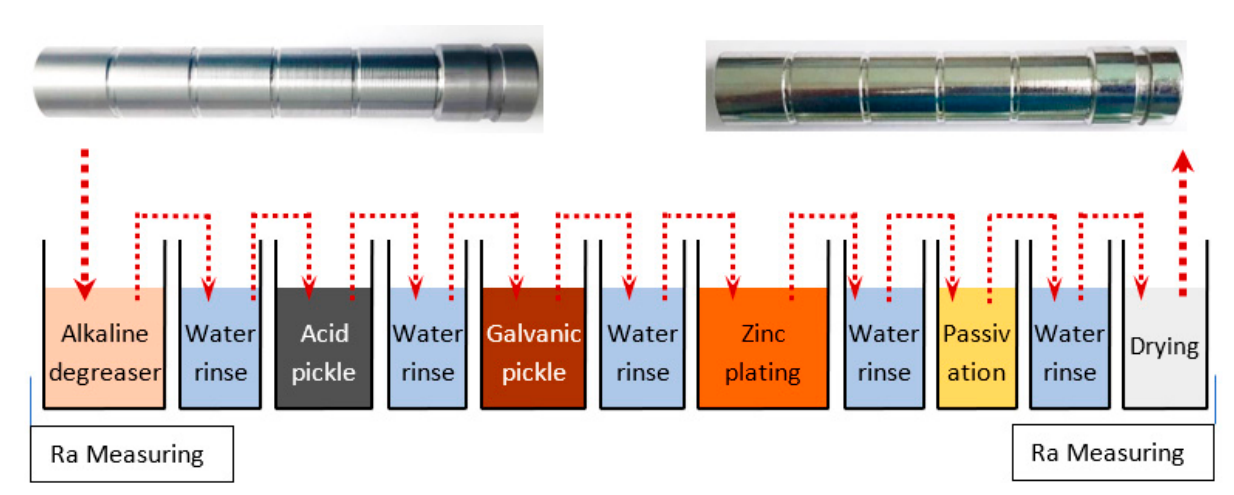
Figure 7. Specific technological flow of galvanic galvanizing. The characteristics of the baths in which the electrolytic treatment was carried out are presented below: